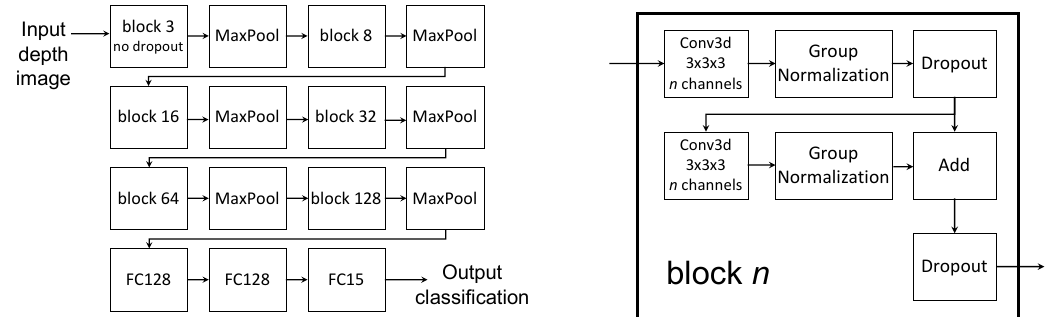
Figure 4. The neural network structure used for the depth map based classification